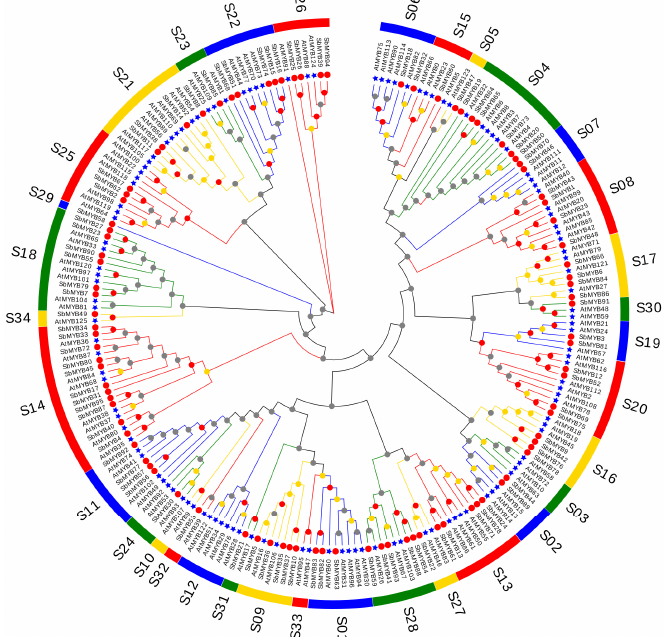
Figure 2. S. baicalensis (red) and Arabidopsis (blue) R2R3-MYB proteins phylogenetic relationships. A neighbor-joining (NJ) phylogenetic tree was generated using 1000 replications. A total of 34 sub- groups of R2R3-MYBs (S1–S34) were determined along with Arabidopsis homologs. The red circle refers to SbMYBs and the blue star refers to AtMYBs, and the outer circle of the phylogenetic tree contained the ID number of each subgroup.